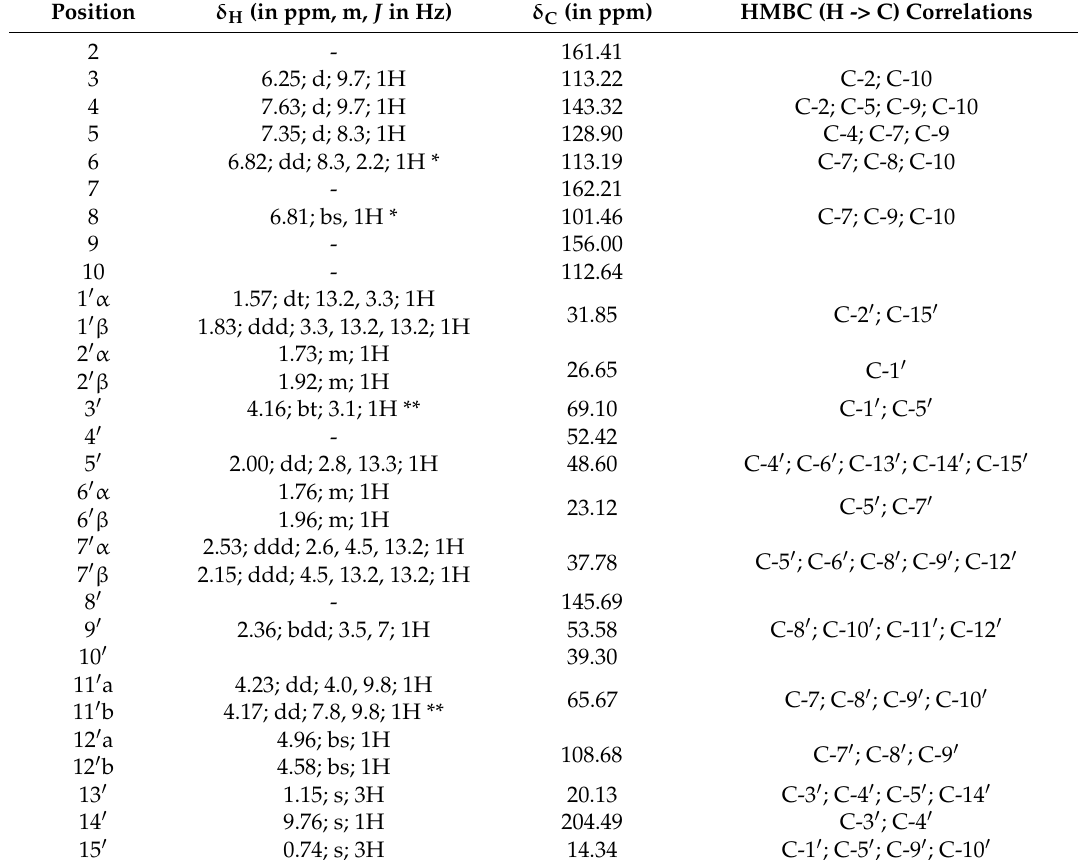
Table 2. 1 H-NMR (600 MHz), 13 C-NMR (150 MHz), and HMBC data of anatolicin ( 8 ) (in CDCl 3